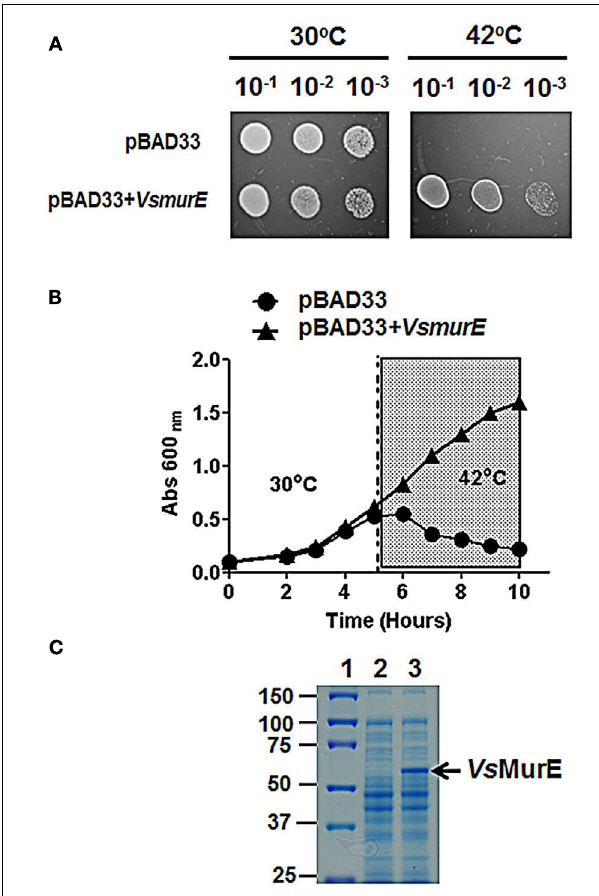
FIGURE 7 | Functional complementation of the E.coli murE mutant. (A) The E. coli mutantTKL-11 harboring pBAD33 or pBAD33 + VsmurE .The bacteria were grown to an OD of 0.1 at 600nm and were serially diluted to 10 − 1 , 10 − 2 , and 10 − 3 using 0.85% (w/v) saline.The bacteria were replica-plated on LB medium supplemented with 0.2% (w/v) arabinose.The growth was assessed at 30 and 42˚C after 24h. Only one colony from the vector only and recombinant plasmid was used to create the diagram. (B) Growth curve of E. coli TKL-11 harboring either the empty vector pBAD33 (circles), or pBAD33 + VsmurE (triangles).The cells were grown at 30˚C for 5h then shifted to 42˚C for an additional five hours (shaded area). (C) SDS-PAGE analysis of proteins extracted fromTKL-11 grown in LB supplemented with 0.2% arabinose (w/v). Lane (1) protein ladder (kDa), Lane (2) 10 μ g of soluble protein extract fromTKL-11 harboring pBAD33 grown at 30˚C, Lane (3) 10 μ g of soluble protein extract harboring pBAD33 + VsmurE grown at 42˚C.The proteins were resolved on a 10% (w/v) acrylamide gel and were stained with Coomassie blue for